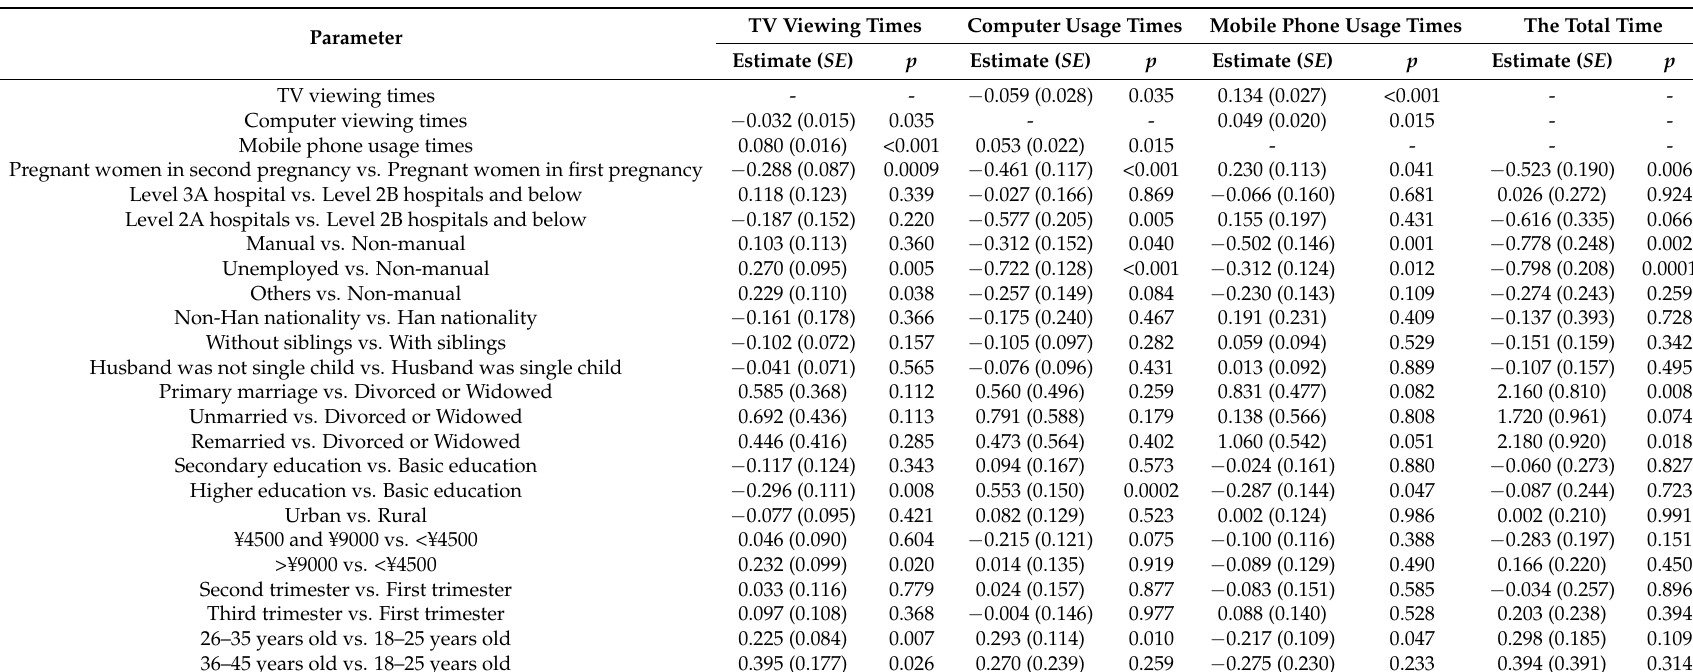
Table 4. Generalized linear model for identifying factors that affect TV viewing times, computer viewing times, mobile viewing times, and total viewing time among pregnant women, China,